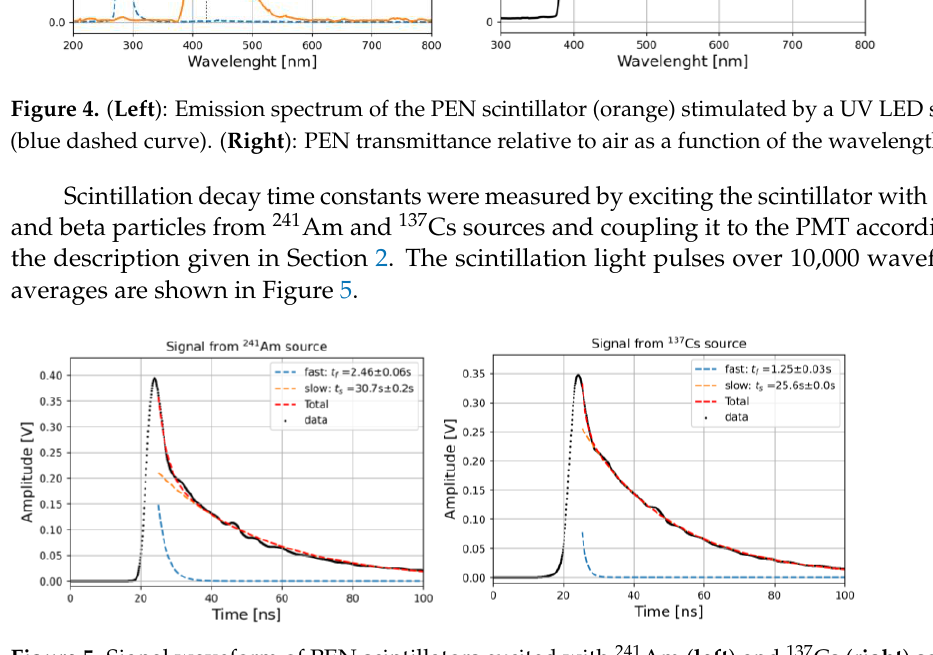
Figure 5. Signal waveform of PEN scintillators excited with 241 Am ( left ) and 137 Cs ( right ) sources. The signals shown are the averages of 10,000 waveforms.